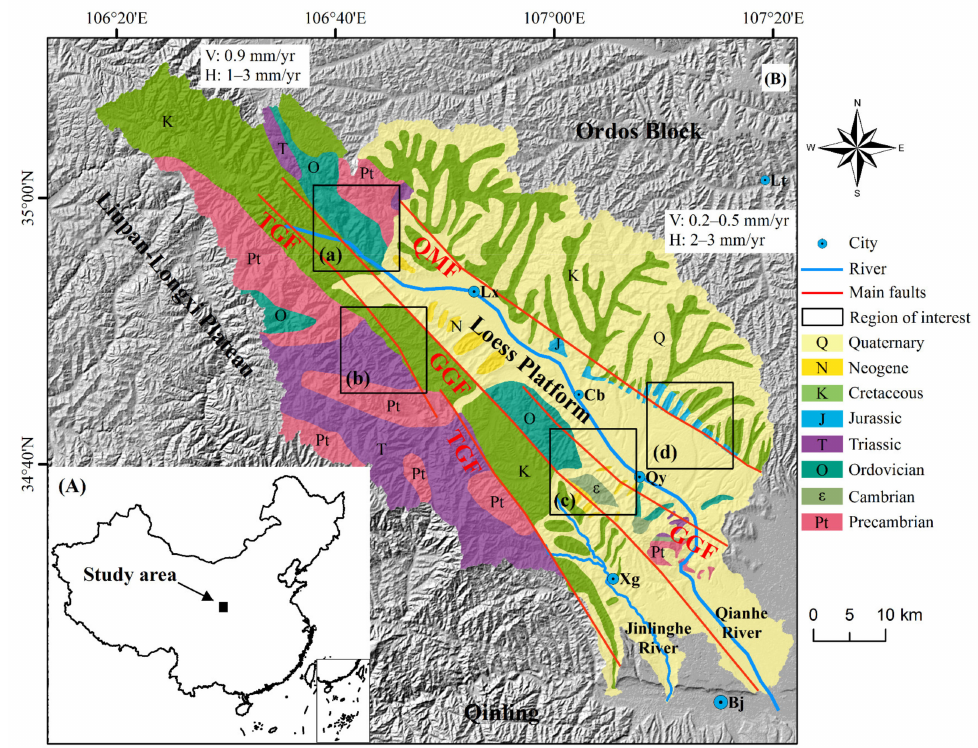
Figure 1. ( A ) Map of China; ( B ) simplified geological map of the Qianhe Graben, modified from [39,49,52] and overlaid with the hillshade map from the Shuttle Radar Topography Mission (SRTM) data (https://earthexplorer.usgs.gov (accessed on 29 December 2020)). The four red lines are active faults in the Qianhe Graben: TGF, Taoyuan–Guichuansi Fault; GGF, Guguan–Guozhen Faults; QBF, Qianyang–Biaojiao Fault; QMF, Qianshan–Mazhao Faults. Cities: Lx, Longxian; Cb, Caobi; Qy, Qianyang; Xg, Xiangong. (a), (b), (c), and (d) are the regions of interest. The horizontal and vertical slip rates were collected from [48]. All data were reprojected into WGS_1984_UTM_Zone_48N, and the datum was